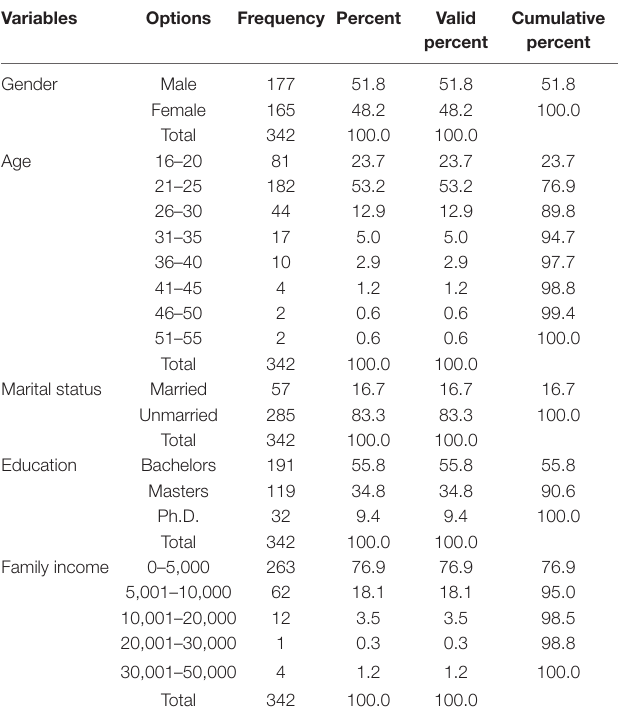
TABLE 2 | Profile of respondents from China.